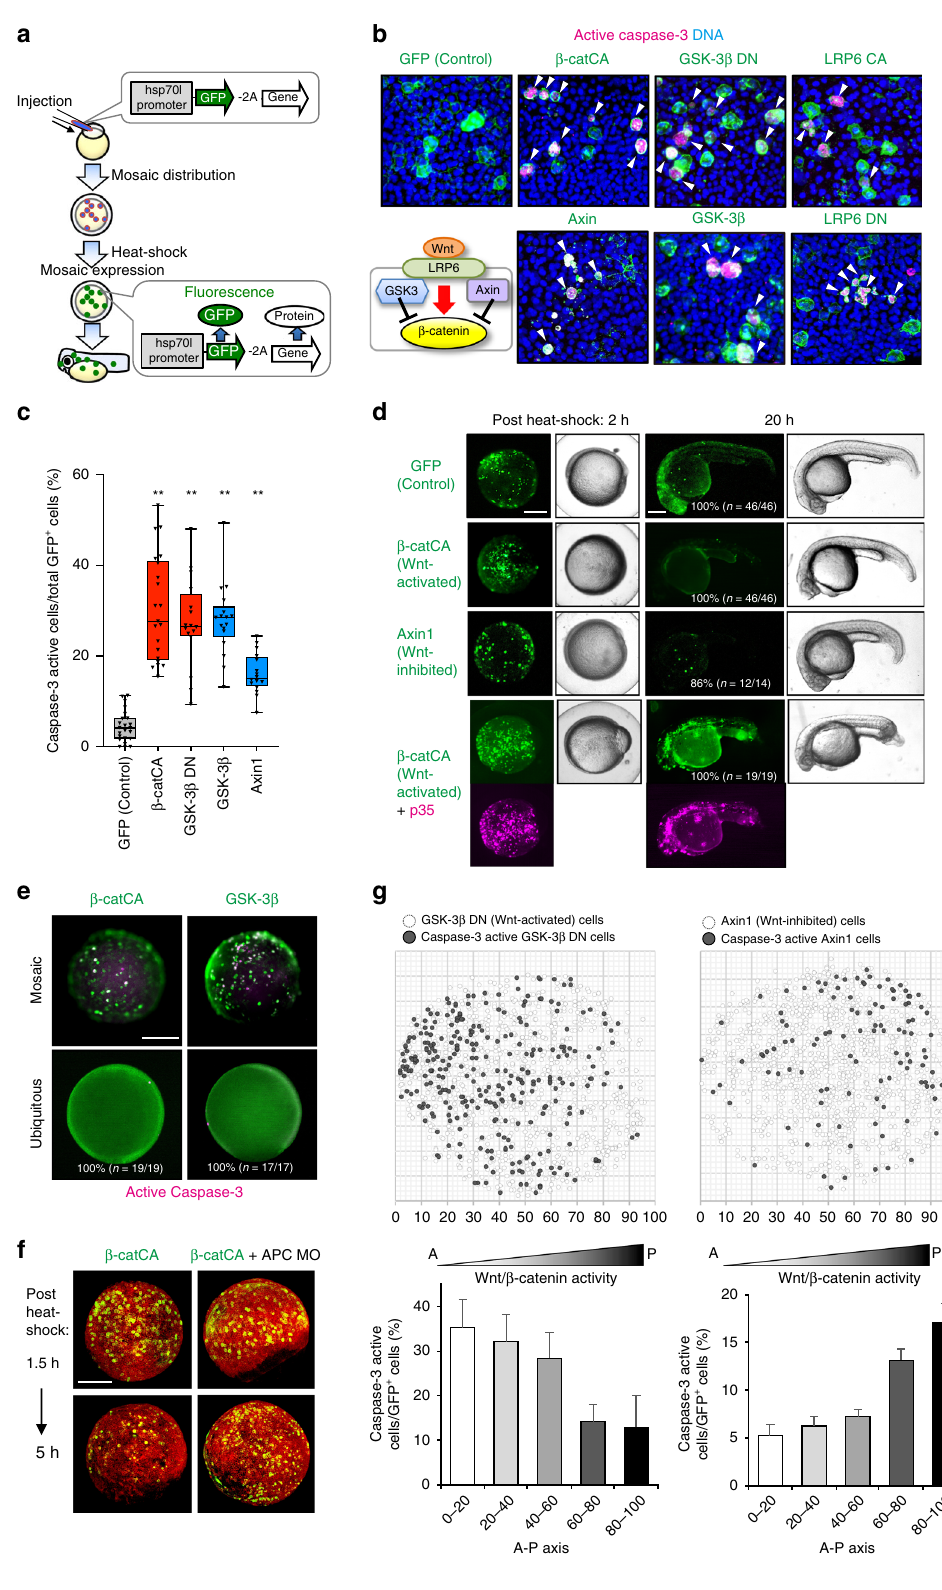
Supplementary Fig. 5e, check-marks). We also con fi rmed that skilb expression was downregulated in naturally generated un fi t cells with abnormally high or low Wnt/ β -catenin activity (Supplementary Fig. 5f). These results suggest that Smad signalling is upregulated in un fi t cells. Smad family proteins